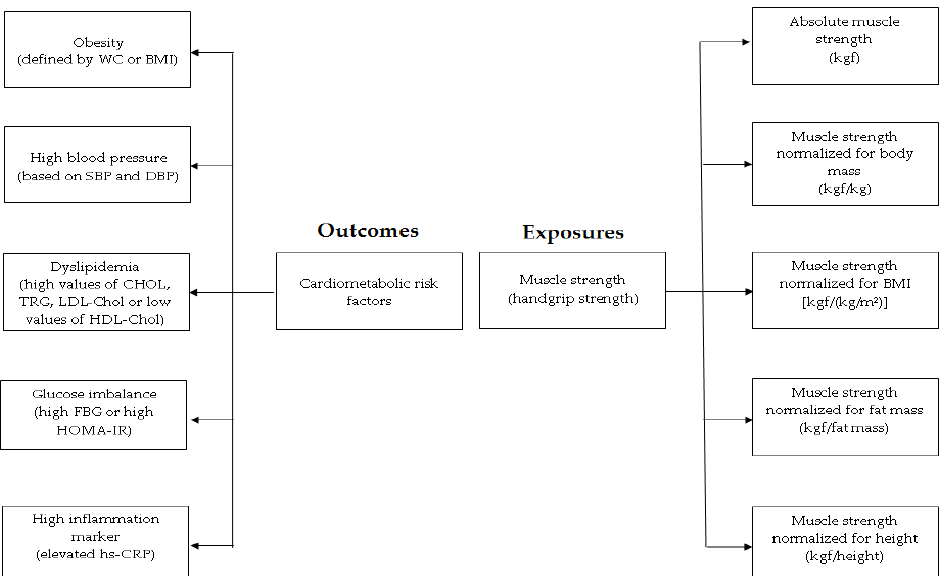
Figure 1. Diagram of the investigated variables. WC: waist circumference; BMI: body mass index; SBP: systolic blood pressure; DBP: diastolic blood pressure; CHOL: cholesterol; TRG: triglycerides; LDL-Chol: low-density lipoprotein cholesterol; HDL-Chol: high-density lipoprotein cholesterol; FBG: fasting blood glucose; HOMA-IR: homeostatic model assessment for insulin resistance hs-CRP: high-sensitivity C-reactive protein.